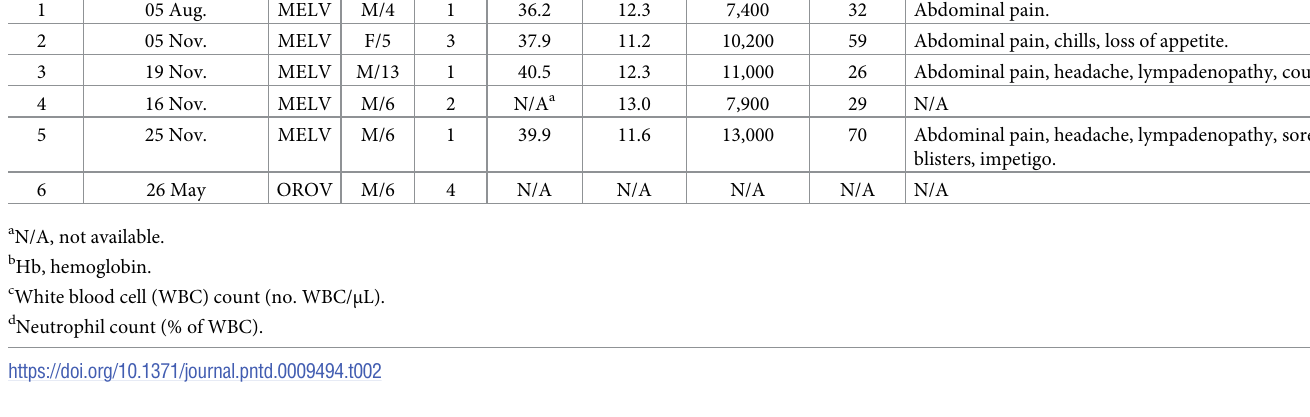
Table 2. Demographic and clinical data for six orthobunyavirus infection cases. Child Clinic visit date (yr. ID 2014)